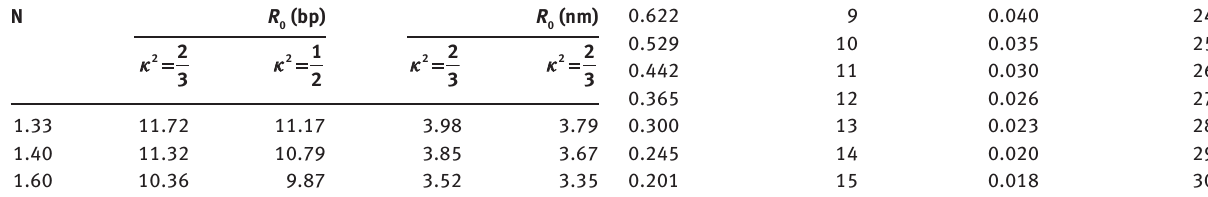
Table 3 Calculated values of R